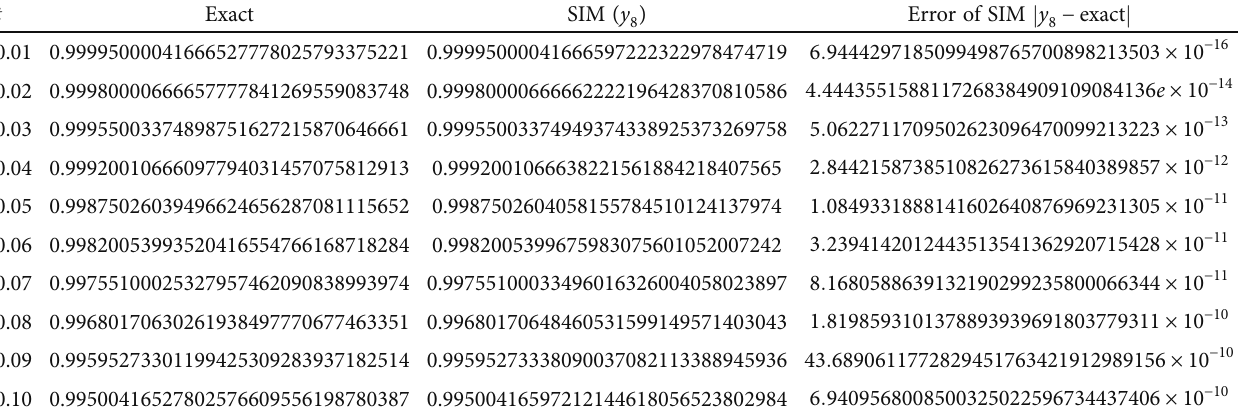
ff erent values of t